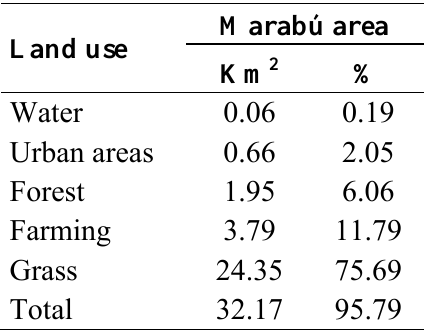
Table 6. Marabú distribution ( Dychrostachys cinerea ) in terms of land use (taking 1985 as a reference